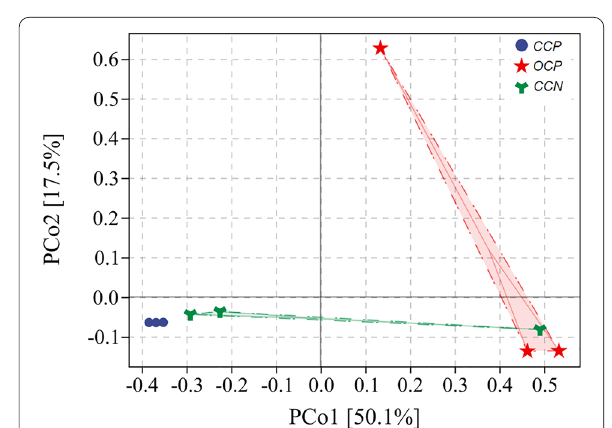
Fig. 6 Distance matrix and PCoA analysis under different conditions in